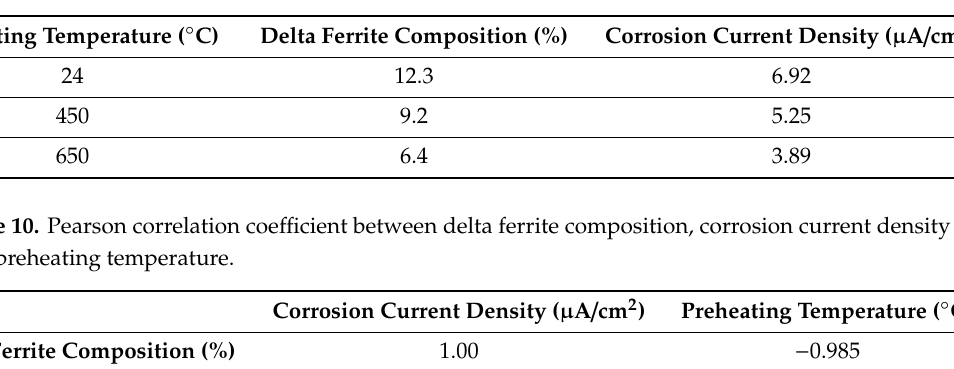
Table 9. Corrosion current density and delta ferrite composition of austenitic stainless steel at di ff erent preheating temperatures [1].